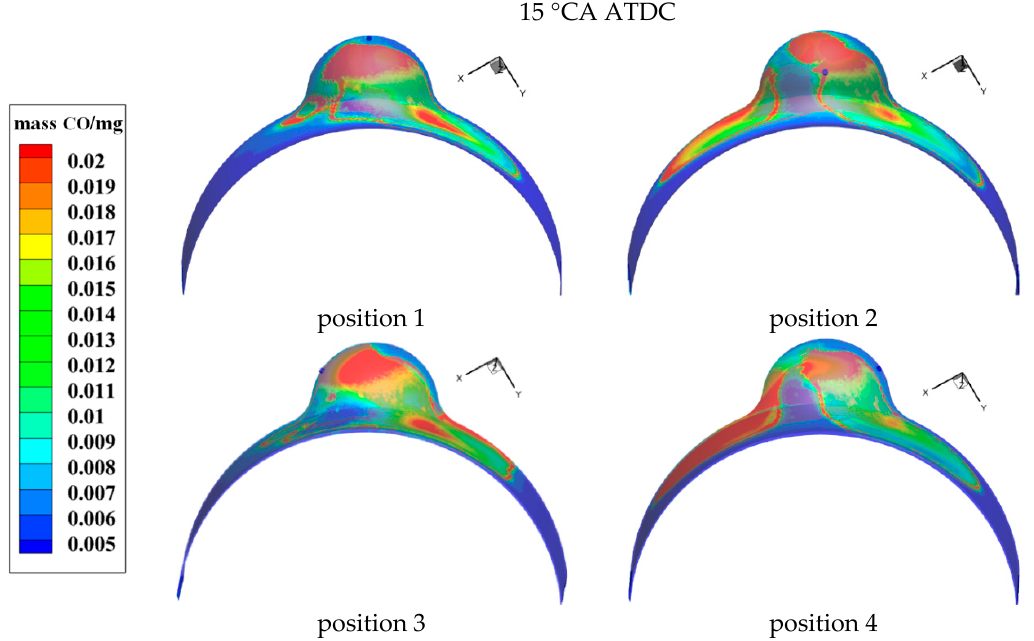
Figure 13. Comparison of CO distribution cloud atlas in combustion stage at different positions.